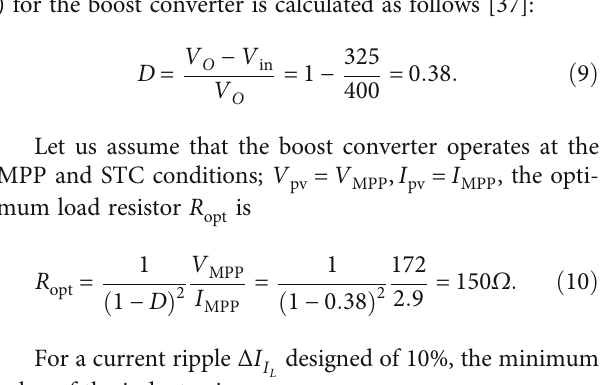
Figure 3: STC characteristics.